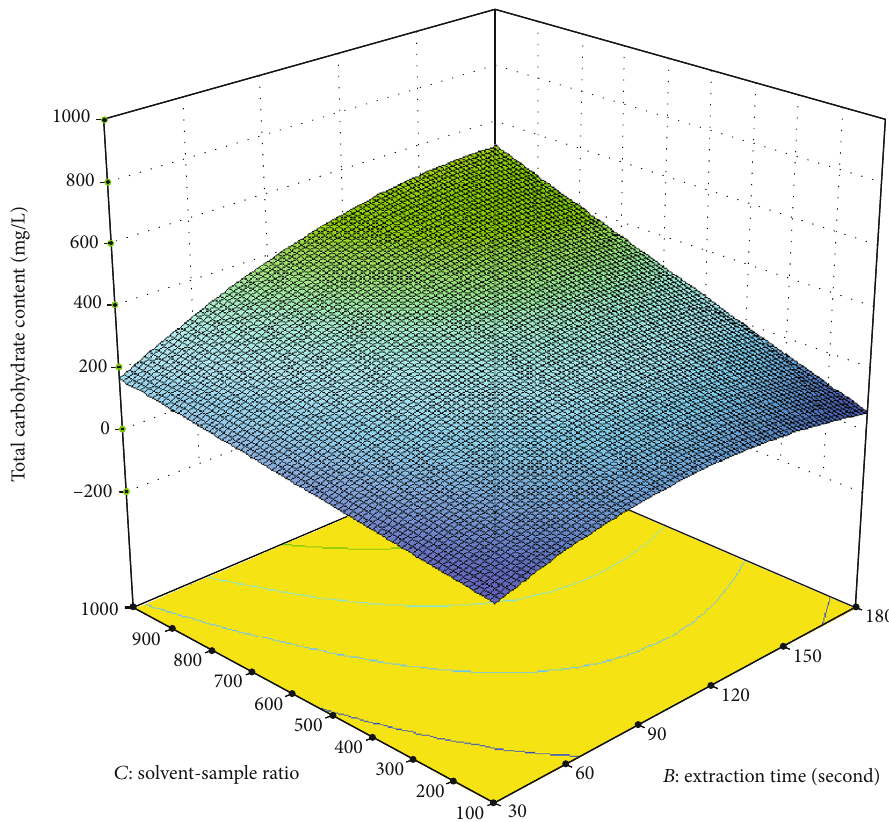
Figure 2: Response surface plot showing the e ff ect of extraction time and solvent-sample ratio on the total carbohydrate